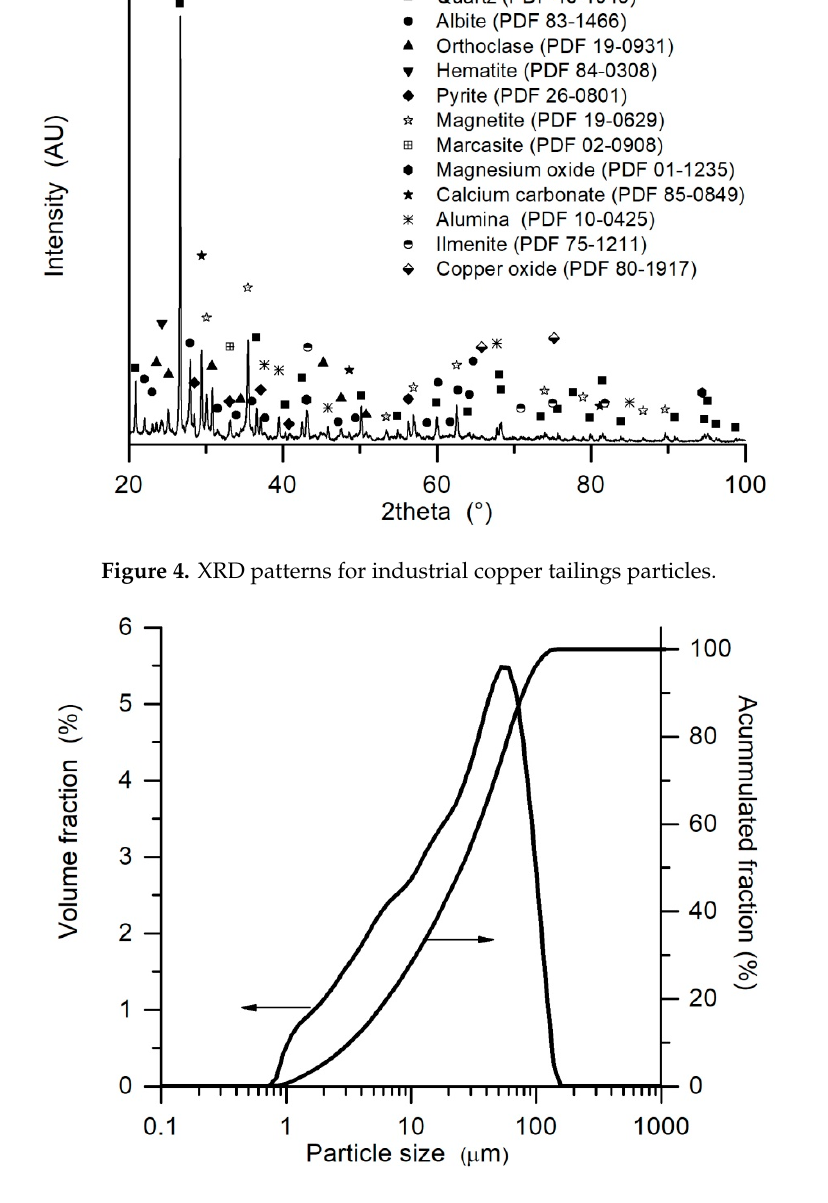
Figure 5. Particle size distribution of industrial copper tailings.